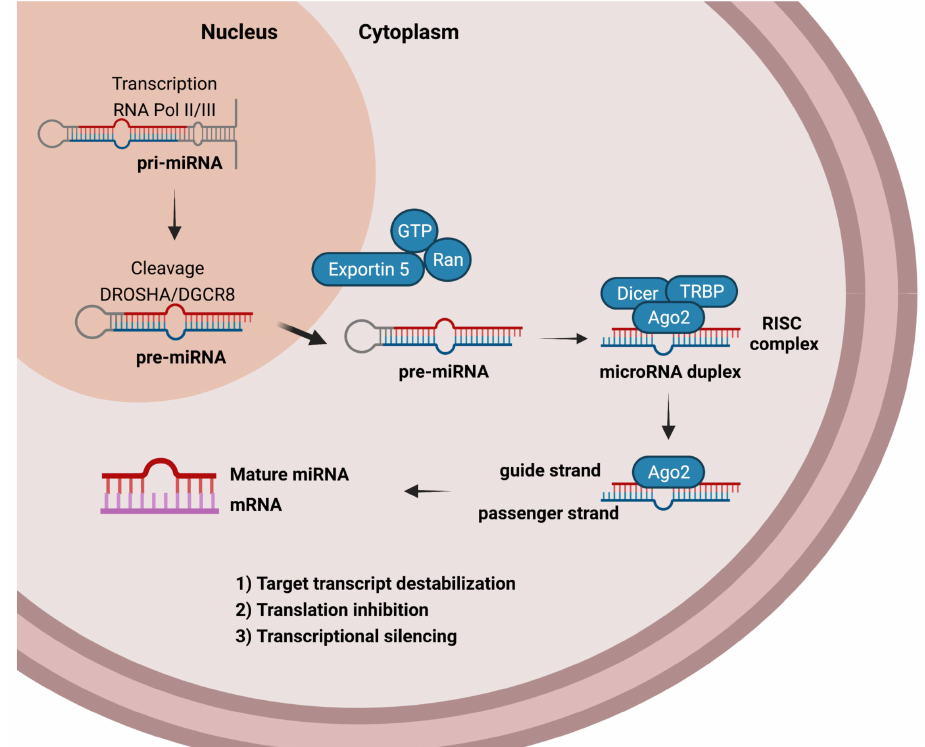
Figure 1. Overview of miRNA biogenesis. Biogenesis consists of the miRNA gene transcription and maturation that involves the following steps: Pri-miRNA processing by DROSHA; Processing of pre-miRNA by DICER; Other modifications to produce mature miRNA and RISC complex formation to further mature miRNAs regulate mRNA and consequently interfere in protein production. Figure created by authors using